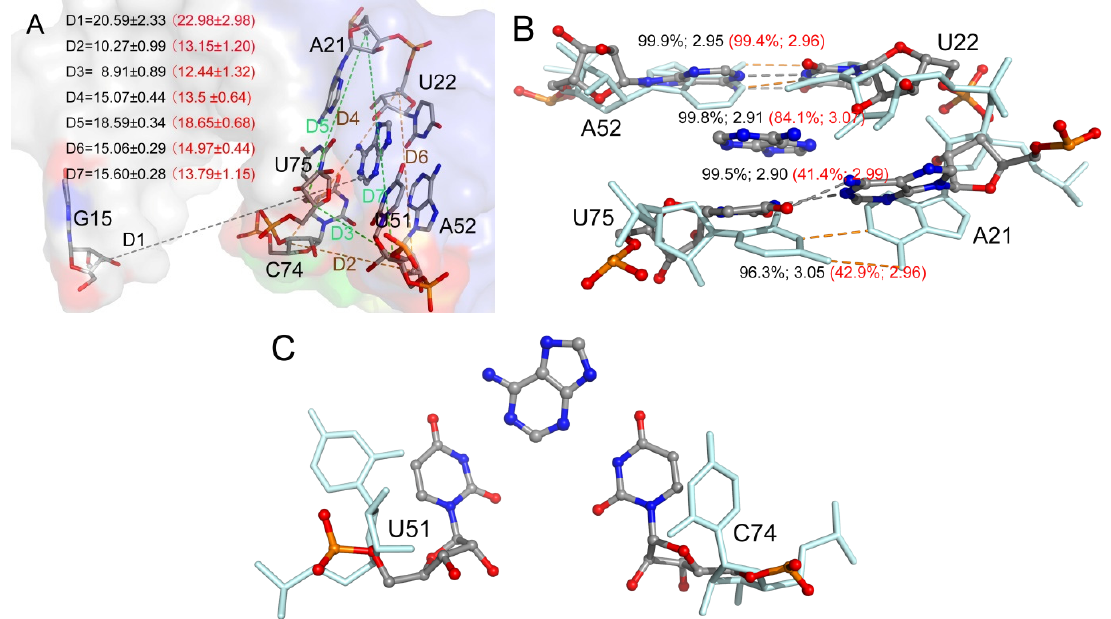
Figure 6. ( A ) Seven average distances labeling the binding pocket and conformational change between the mass centers of the backbone atoms of two nucleotides. The distance values with standard deviation are shown for the complex and monomer in black and red colors, respectively. ( B ) The H-bonds formed between key nucleotides in the binding pocket labeled with occupancies and average distances. ( C ) The position of two key nucleotides U51 and C74 in the complex and monomer.